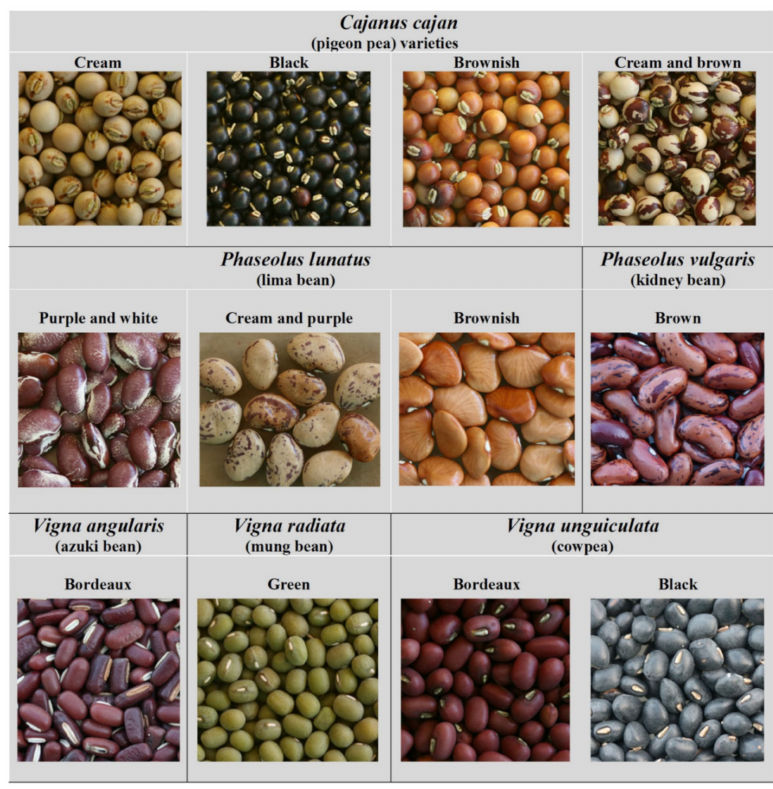
Figure 2. Sampled species and types according to their seed